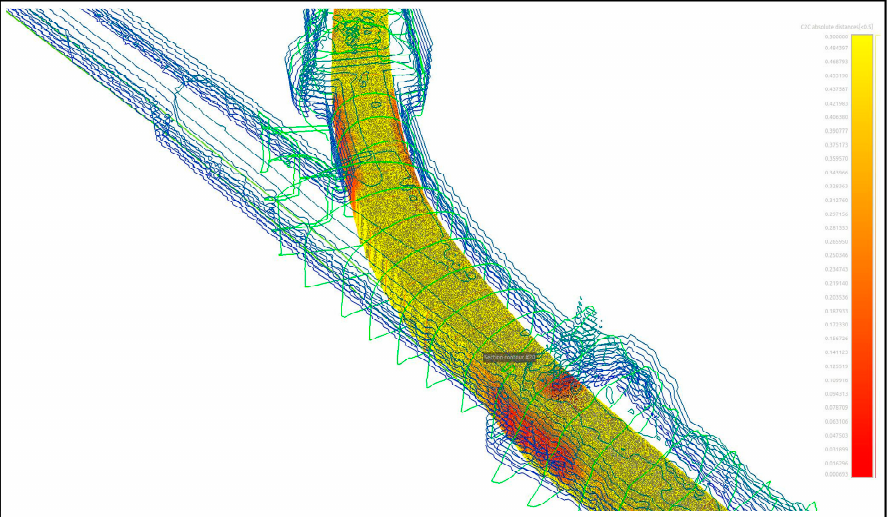
Figure 15. 3D model for the purpose of analysis of collision possibility.